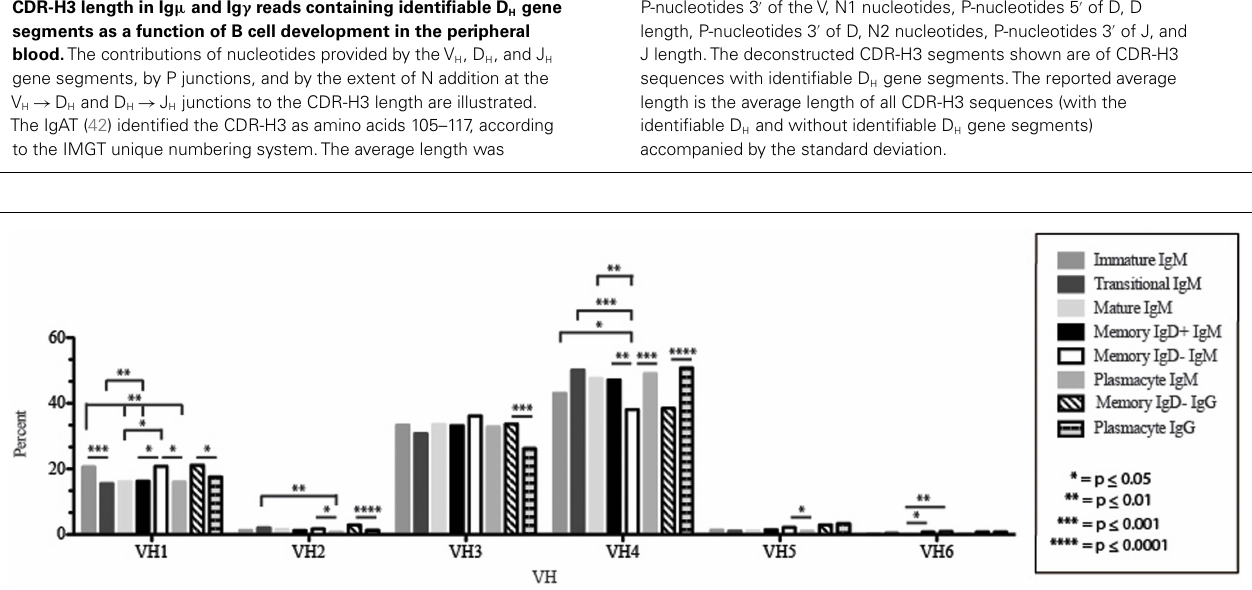
FIGURE 3 |V H gene segment usage in Ig µ and Ig γ transcripts from selected B cell populations in the blood of a normal, healthy human. V H gene segments are arranged according to their position relative to the J H locus in the genome. Percent of unique, in-frame sequences using the V H gene segment specified in the peripheral blood from immature,